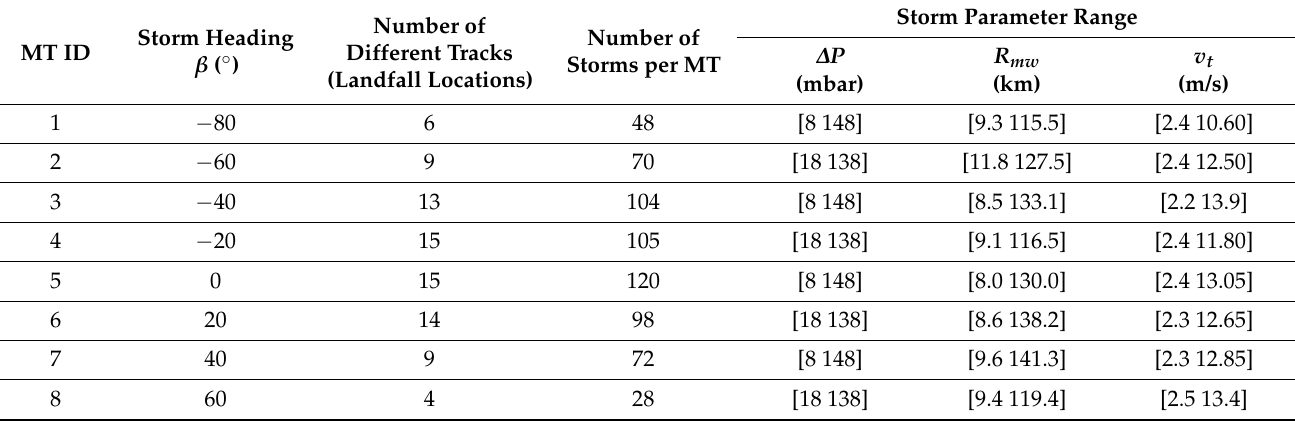
Table 1. Characteristics of the database per master track